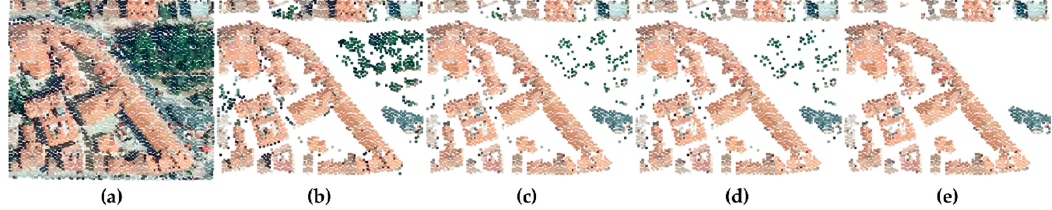
Figure 3. Point cloud filtering process: ( a ) original, ( b ) after removing points belonging to the ground, ( c ) after removing points belonging to vegetation areas, ( d ) after removing points belonging to building façades, ( e ) after removing noise points.